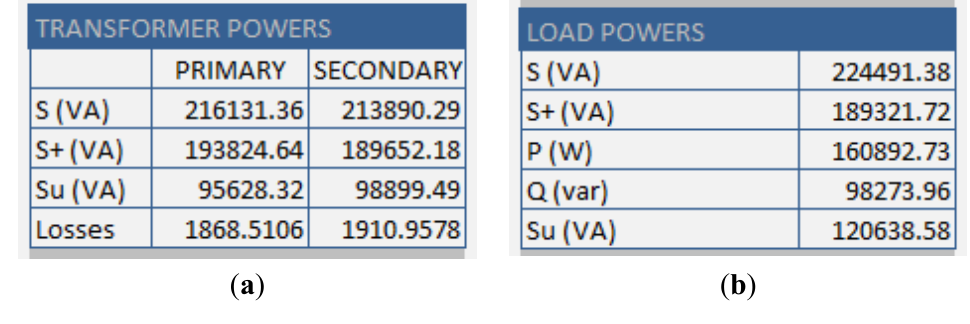
Figure 7. ( a ) Transformer powers and losses; ( b ) load powers.